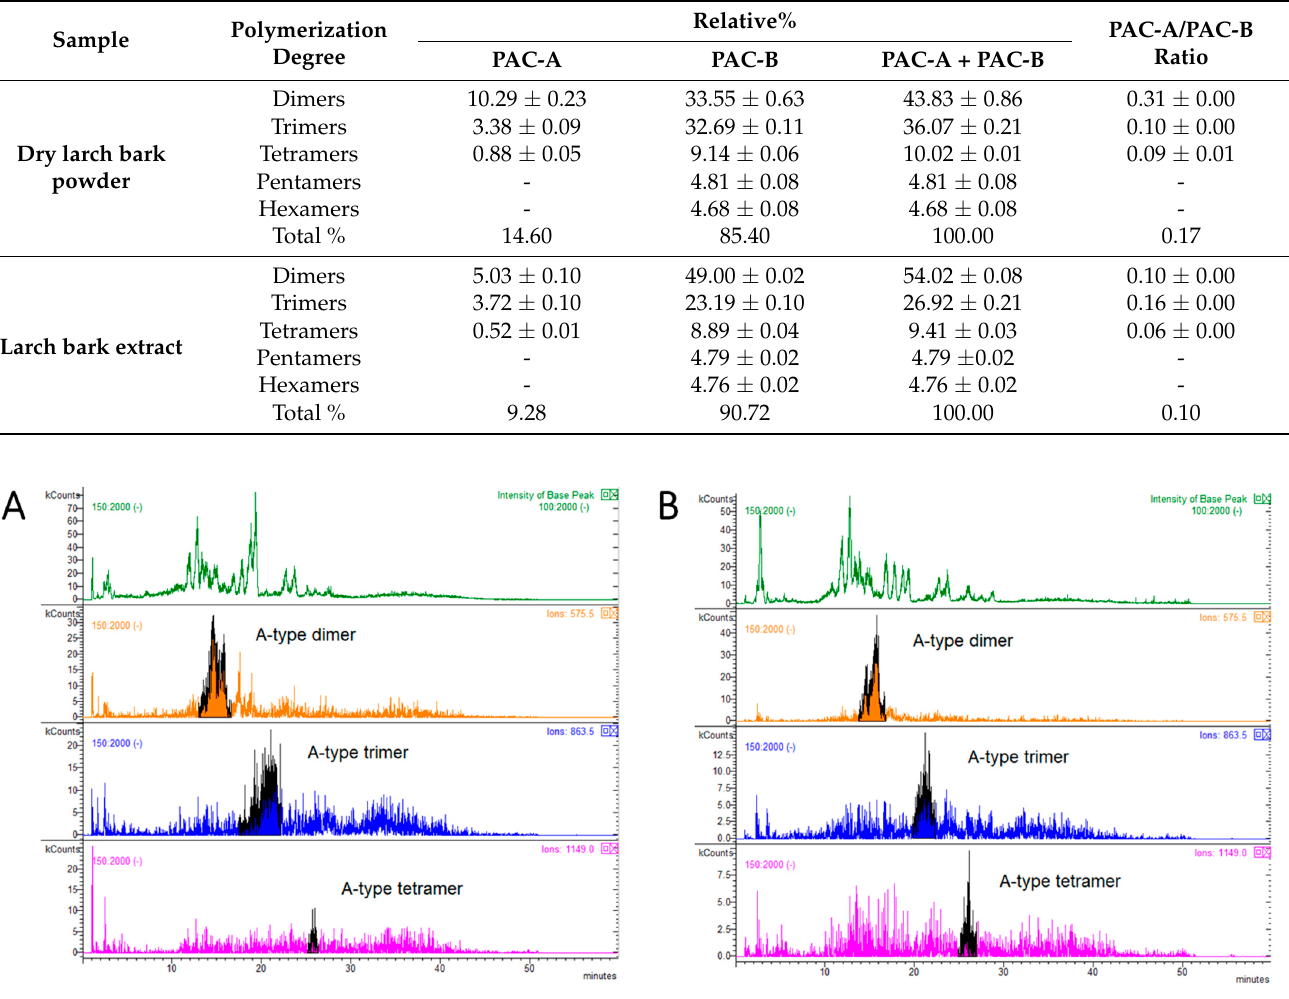
Figure 5. HPLC-MS chromatograms showing the distribution of type -B procyanidins in dry larch bark powder (panel A ) and larch bark extract (panel B ). Table 2. Relative PAC-A and PAC-B % and PAC-A/PAC-B ratio related to polymerization degree of PACs contained in dry larch bark powder and in larch bark extract. Data were obtained by HPLC-MS analysis and are expressed as % w / w ± SD. Sample